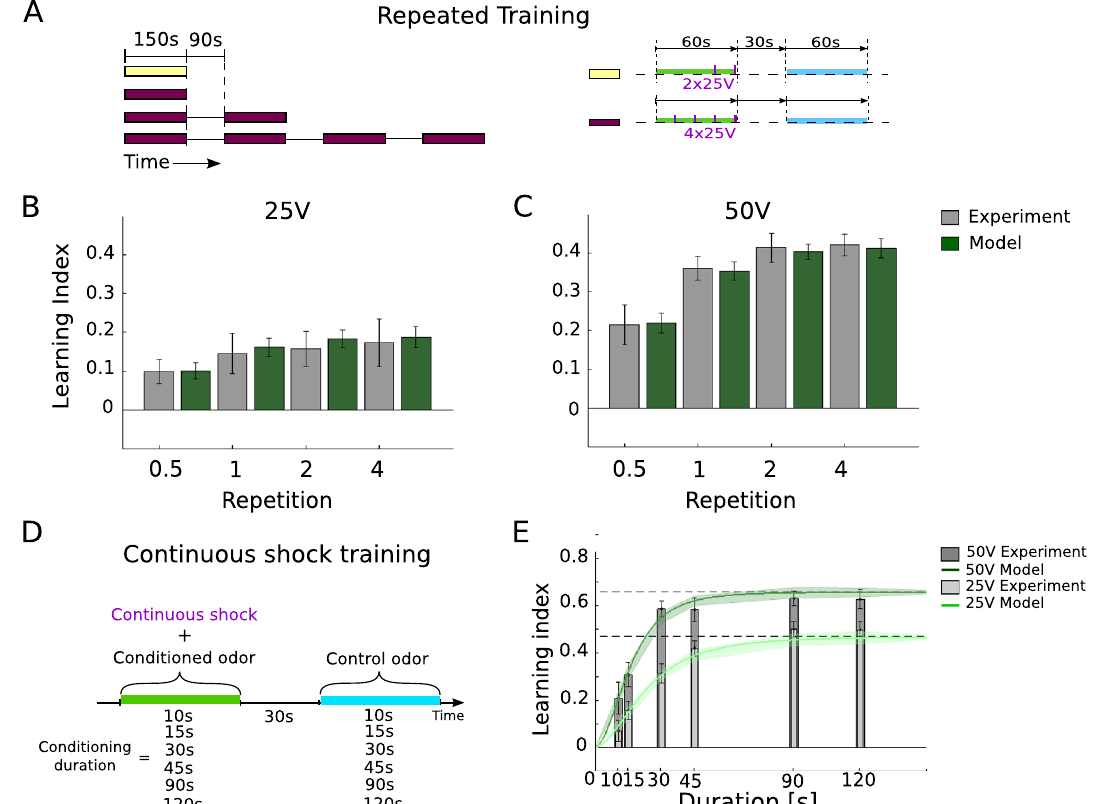
Figure 4. Repetitive and ongoing conditioning is captured by the predictive plasticity. (A) The repeated training consisted of 1, 2, 4 repetitions of a standard training block (dark red bar, as in Fig. 3A, A1) composed of 4*25V shocks, followed by a break and a control period. Half of a training block was considered with 2*25V shocks towards the end of the 60s odor presentation (yellow bar). (B) The LI saturates after a full block (1 Repetition, gray), as also reproduced by the predictive plasticity model (green). (C) The same protocol with the same number of shocks as in (B), but with 50V instead of 25V shocks. A second training repetition did only slightly increase the LI and for further repetitions it again remains constant. This is reproduced by the predictive plasticity, but not by the various associative plasticity models (see Supplementary Materials). (D) Protocol of ongoing odor-shock pairing, with voltages turned on during the full odor presentation time of 10s, 15s, 30s, 45s, 90s and 120s, both for 25V and 50V. (E) The LI for the time-continuous pairing saturates with a time constant